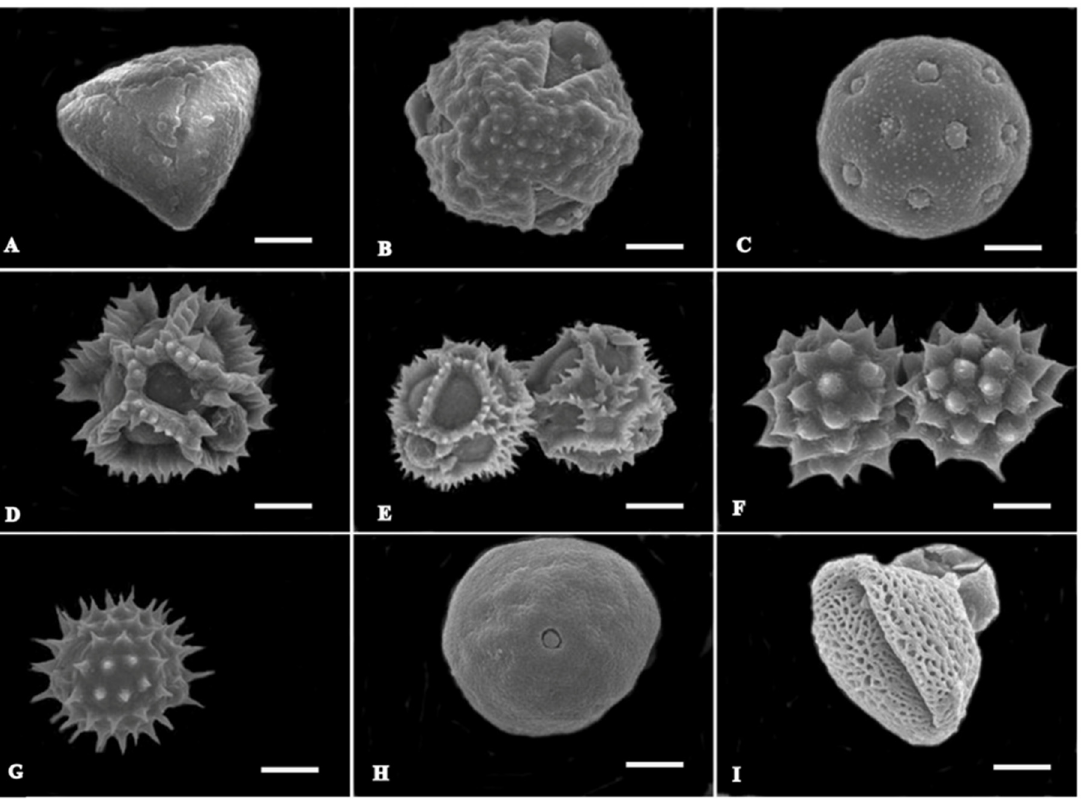
Figure 7. Scanning electron microscopy images of pollen. ( A ) The scale bar represents 5 μ m for Myrtaceae, ( B ) 10 μ m for Artemisia spp. (Asteraceae), ( C ) 5 μ m for Chenopodiaceae, ( D ) 5 μ m for Cichoriodeae (Asteraceae), ( E – G ) 10 μ m for other Asteraceae, ( H ) 5 μ m for Poaceae, and ( I ) 5 μ m for Lamiaceae.